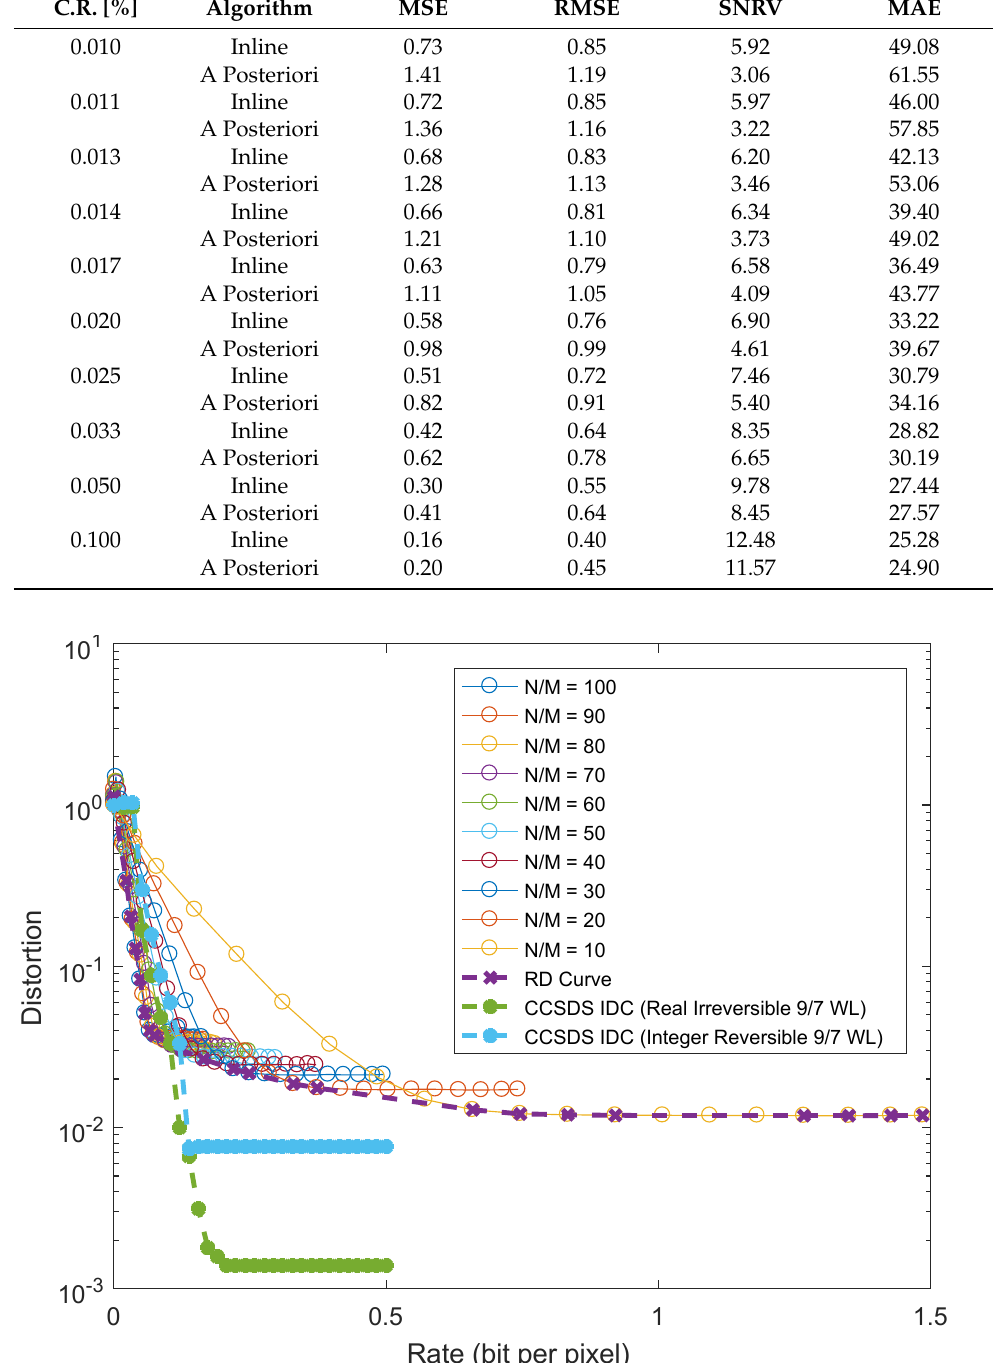
Figure 13. Rate-distortion analysis: distortion (MSE) of the reconstructed image as a function of rate in bits per measurement.